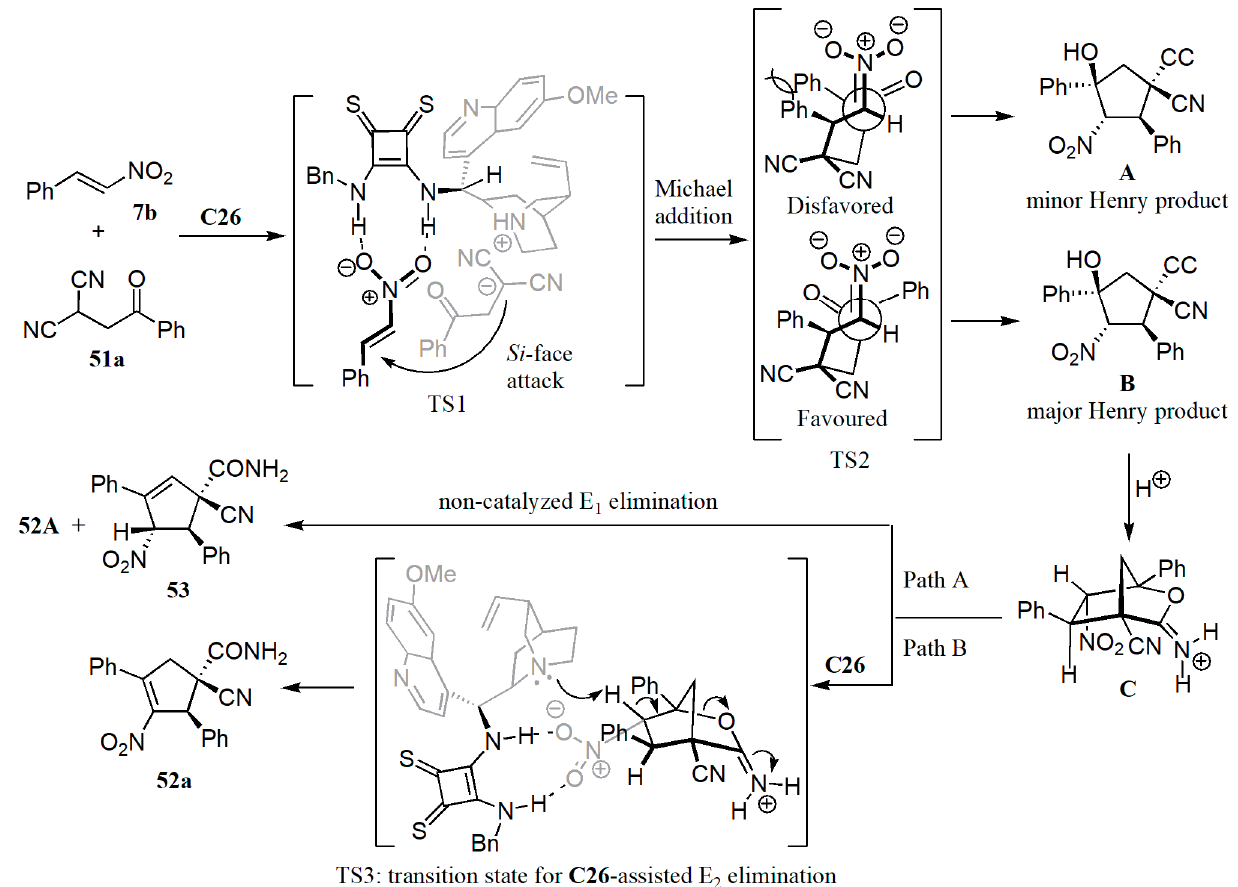
Figure 34. Mechanism proposed for the Michael–Henry–elimination cascade leading to cyclopentenes [66].